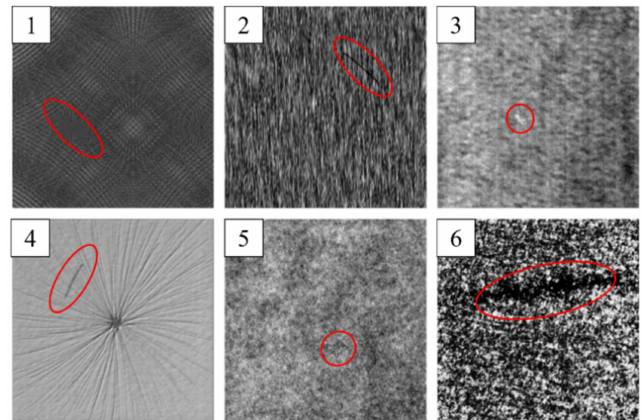
Figure 4. Image samples of six classes from the DAGM dataset.